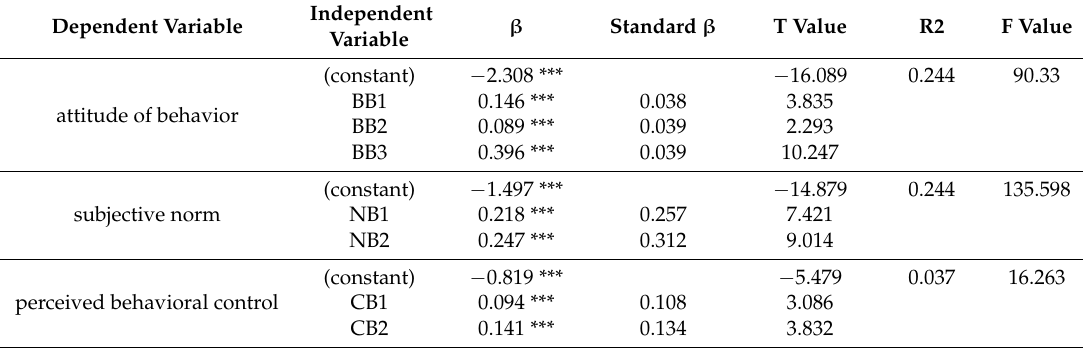
Table 5. Regression analysis of beliefs on the three dimensions of planned behavior